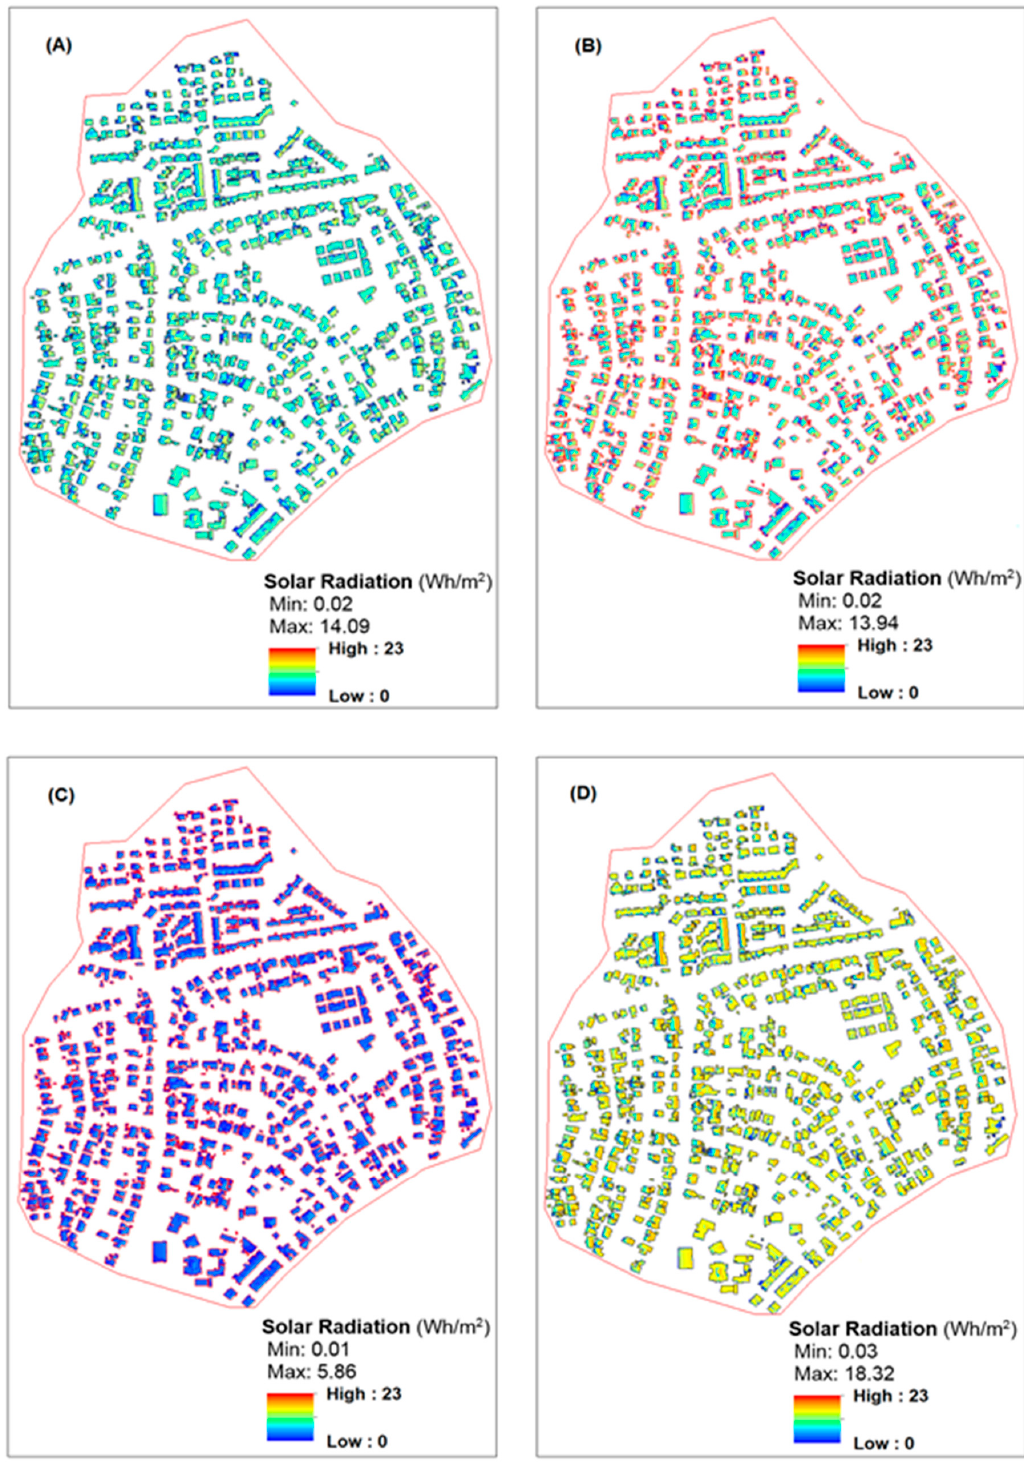
Figure 11. Incoming solar radiation (Wh / m 2 ) at 9:00: ( A ) vernal equinox (21 March), ( B ) autumnal equinox (23 September), ( C ) winter solstice (22 December), and ( D ) summer solstice (21 June).